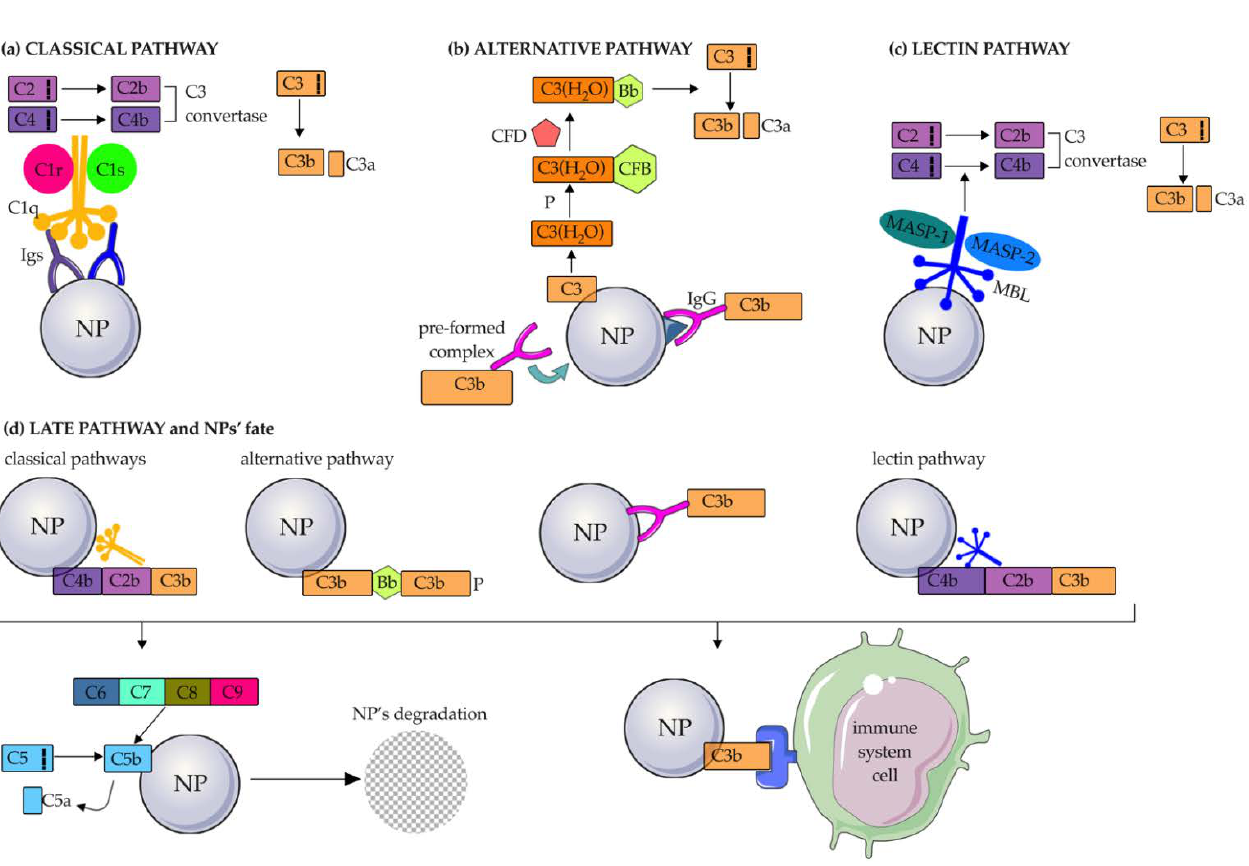
Figure 4. Activation of the complement system on NPs. Schematic representation of the complement activation on the surface of nanoparticles through the ( a ) classical, ( b ) alternative, and ( c ) lectin pathways till the late pathway ( d ). Igs: immunoglobulins; P: properdin; CFB: complement factor B; CFD: complement factor D; MASP: mannan-binding lectin-associated serine protease; MBL: mannose-binding lectin; ag: antigen. The figure was partly generated using Servier Medical Art by Servier, licensed under the Creative Commons Attribution 3.0 Unported Licence.